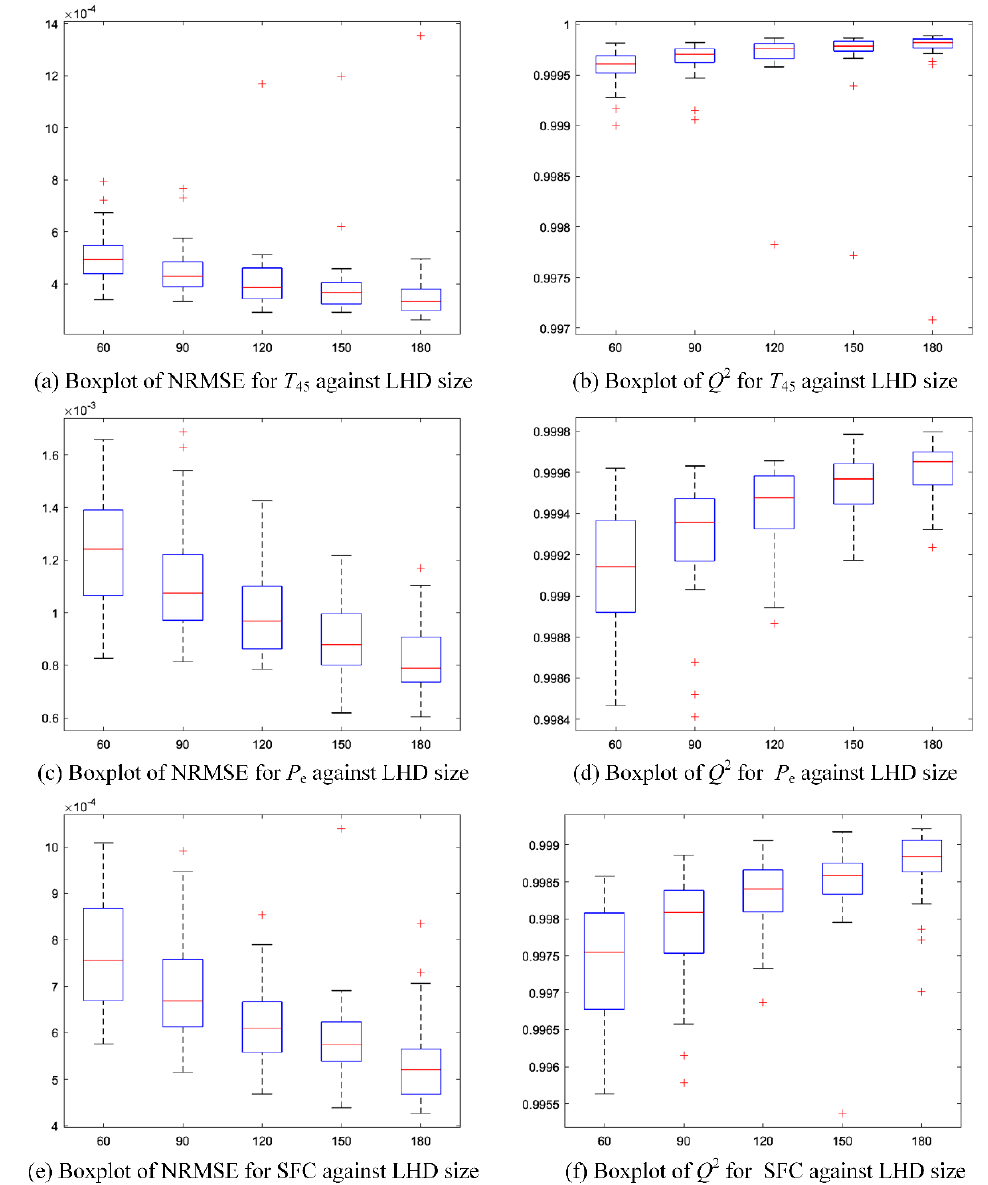
Figure 3. ( a ) The boxplots of NRMSE for T 45 against Latin hypercube design (LHD) size; ( b ) the boxplots of Q 2 for T 45 against LHD size; ( c ) the boxplots of NRMSE for P e against LHD size; ( d ) the boxplots of Q 2 for P e against LHD size; ( e ) the boxplots of NRMSE for specific fuel consumption (SFC) against LHD size; ( f ) the boxplots of Q 2 for SFC against LHD